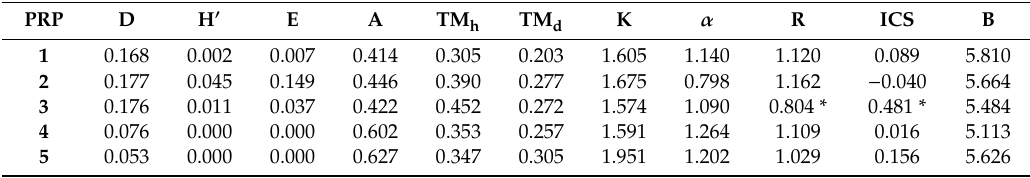
Table 4. Biodiversity indices of forest stand on permanent research plots.